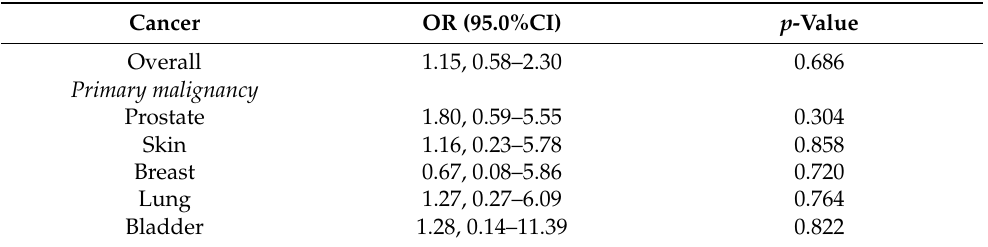
Table 3. Propensity score adjusted machine learning supported multivariable regression of mortality by FFR versus non-FFR PCI among the top 5 cancers for